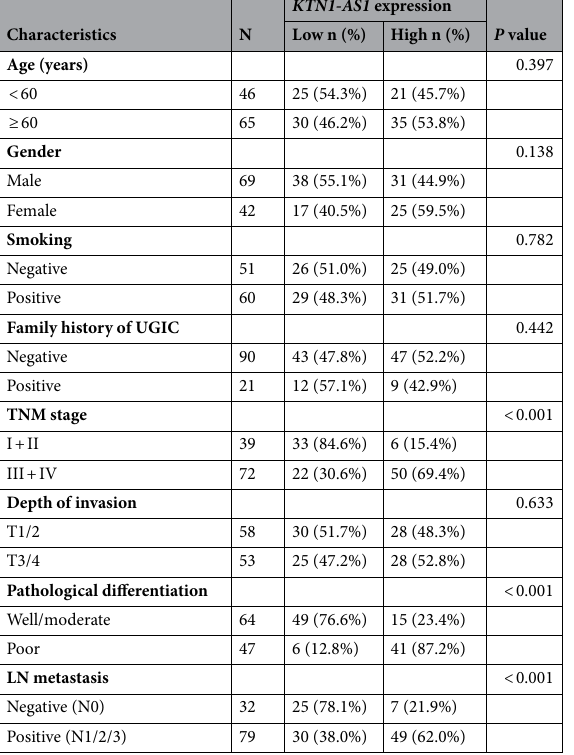
Table 1. Relative expression level of KTN1-AS1 in ESCC patients.